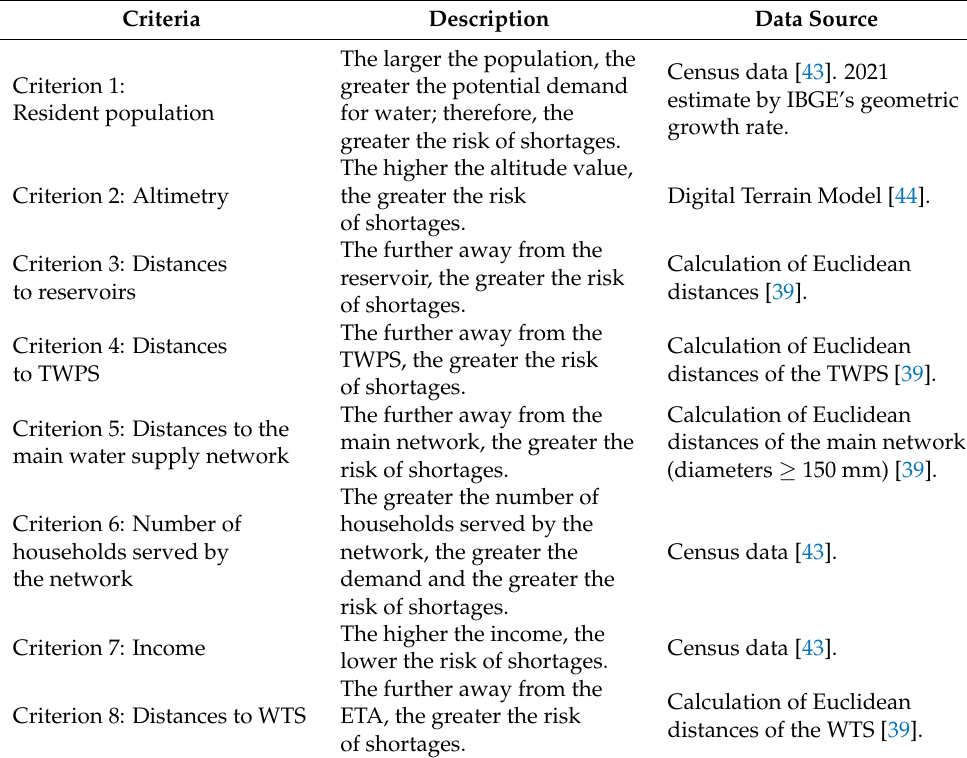
Table 2. Criteria for determining water shortage risks in an urban